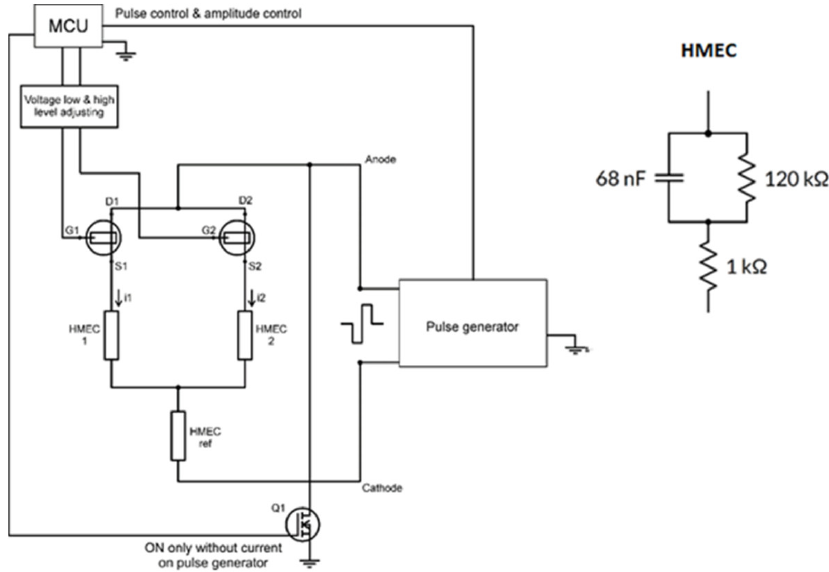
Figure 5. Schematics of the circuit design of the testbed developed for characterization of novel OECT architectures adapted for the requirement of high current and high voltage throughputs in electrical stimulation applications. The MCU controls the logic signal that is directed to the gate electrodes of two OECT devices connected in parallel, and it also generates the current-controlled stimuli via the pulse generator. An additional FET is introduced in the circuit to enable charge consolidation by grounding the OECTs during the period when the stimulation is